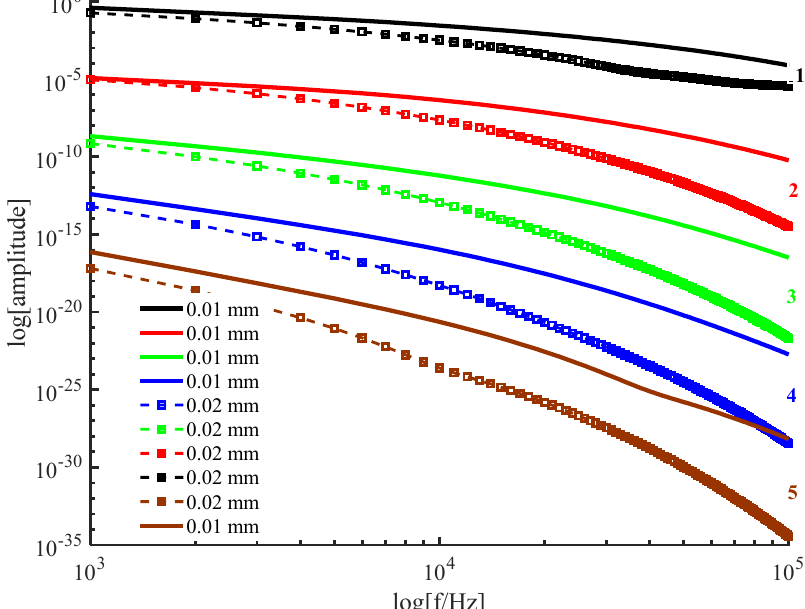
Figure 4. Variation in the harmonic amplitude with frequency for each order of harmonic for different sample thicknesses.